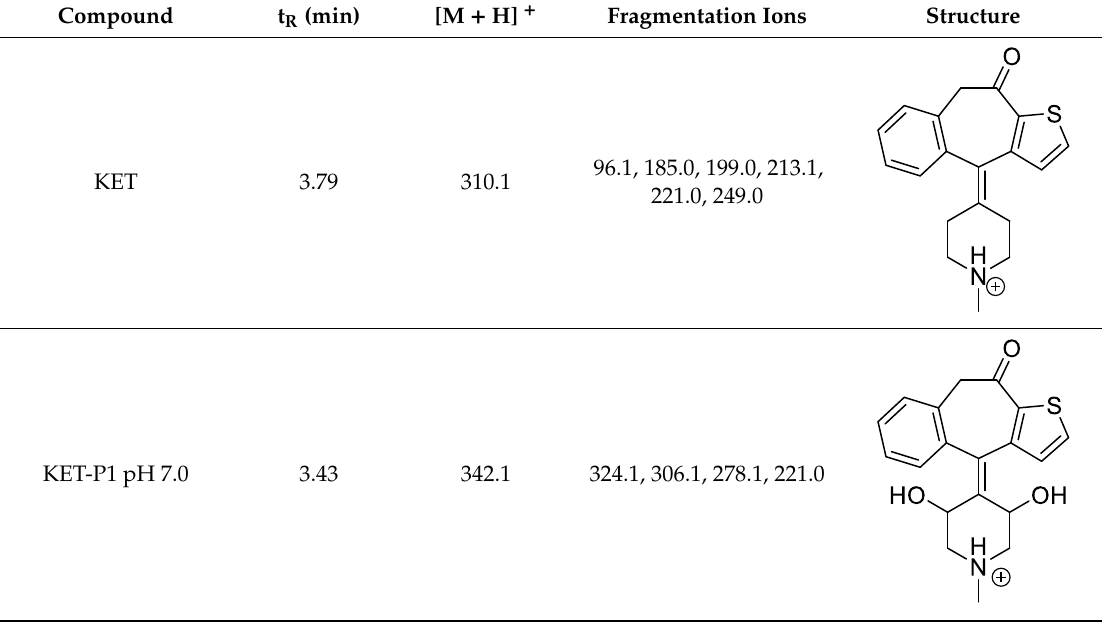
Table 5. Proposed structures of the photodegradation products of ketotifen (KET).